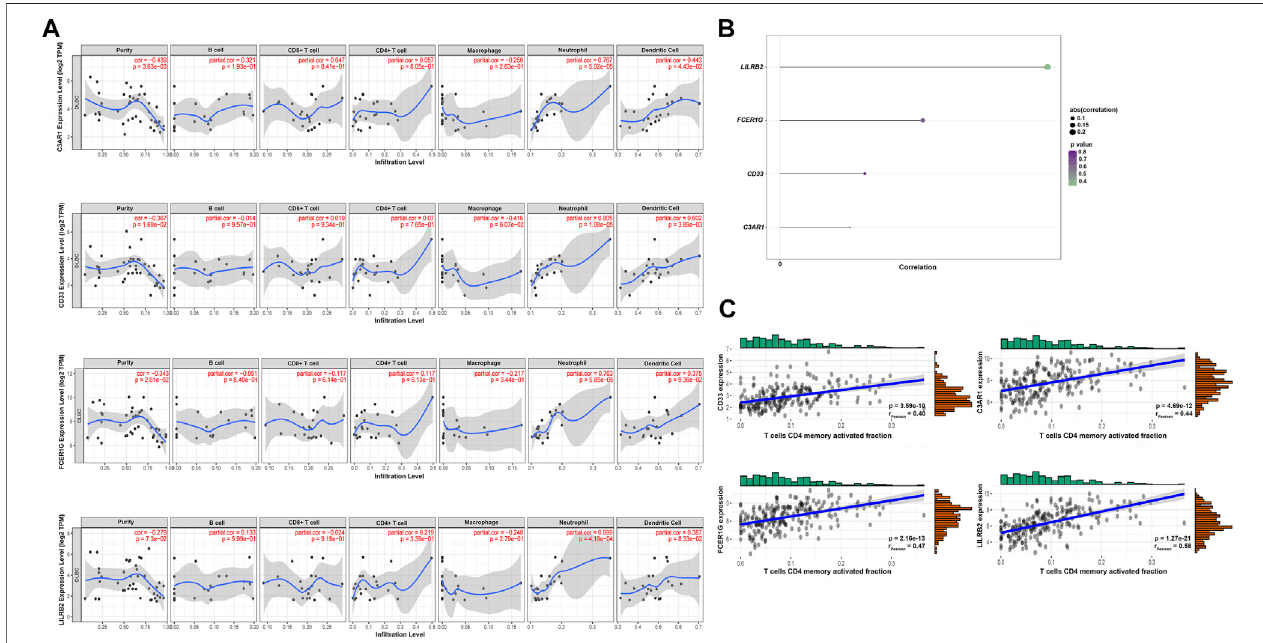
FIGURE 6 | Validation of the hub genes. (A) TIMER database showed the relationship between four genes expression and CD4 + T cells in fi ltration. (B) Lollipop indicated the relationship between four hub genes expression and activated memory CD4 + T cells in fi ltration degree. p -value < 0.05 is considered statistically signi fi cant. (C) Scatter plot of four hub genes expression and activated memory CD4 + T cells in fi ltration